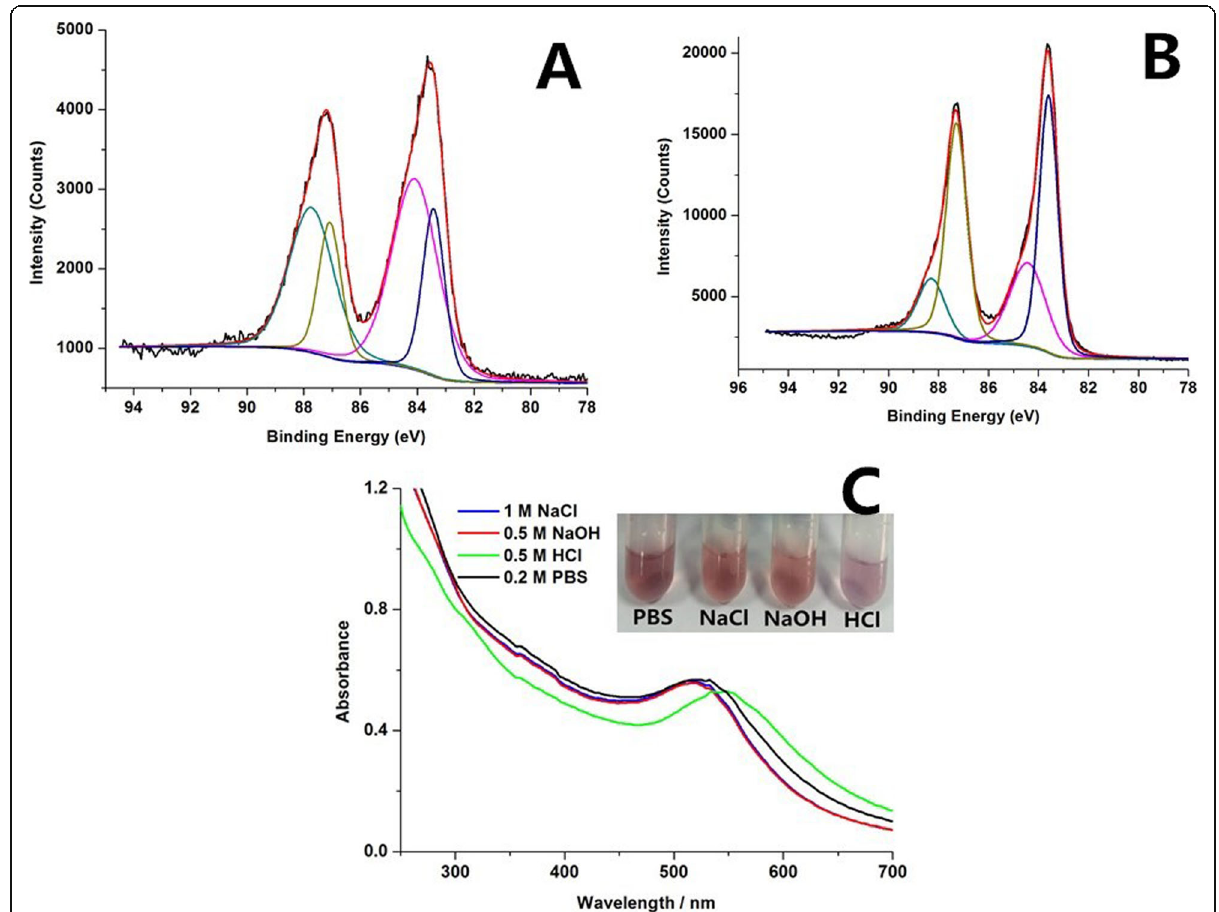
Fig. 3 XPS spectrum of the Au 4f of the ( a ) NLS-GNPs, ( b ) DRN-GNPs. The Au 4f7/2 binding energy of the original spectra (black) and fitted results (red) could be deconvoluted into two components, Au(0)-blue curve and Au(I)-purple curve. UV-Visible absorption spectra and images of DRN-GNPs dispersed in PBS, NaCl, NaOH, and HCl, respectively ( c ).